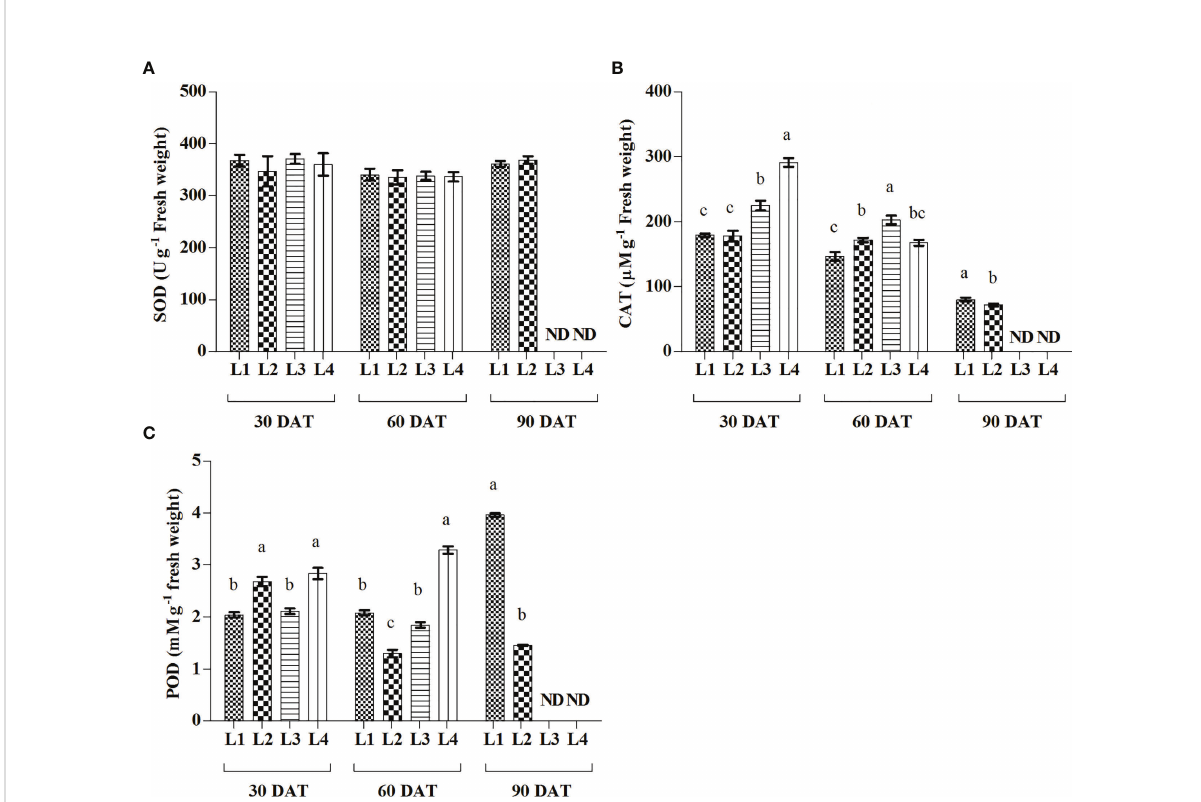
FIGURE 6 Effect of LED spectra on superoxide dismutase (SOD) (A) , catalase (CAT) (B) , and guaiacol peroxidase (POD) (C) of hemp seedlings at 30, 60, and 90 DAT. Here and subsequent fi gures: L1, MW 240 (Red 35% + Blue 25% + Green 40%); L2, FS 240-UV (Red 40% + UVA and Blue 26% + Green 29% + Far red 5%); L3, MB 240 (Red 85% + Blue 15%); L4, PF 240 (Red 70% + Blue 30%); ND, not detected. All treatments used a photosynthetic photon fl ux density of 300 µmol m − 2 s − 1 . Column height indicates the mean, vertical bars indicate the standard error of the mean (n = 4), and different letters indicate signi fi cant differences at p < 0.05.